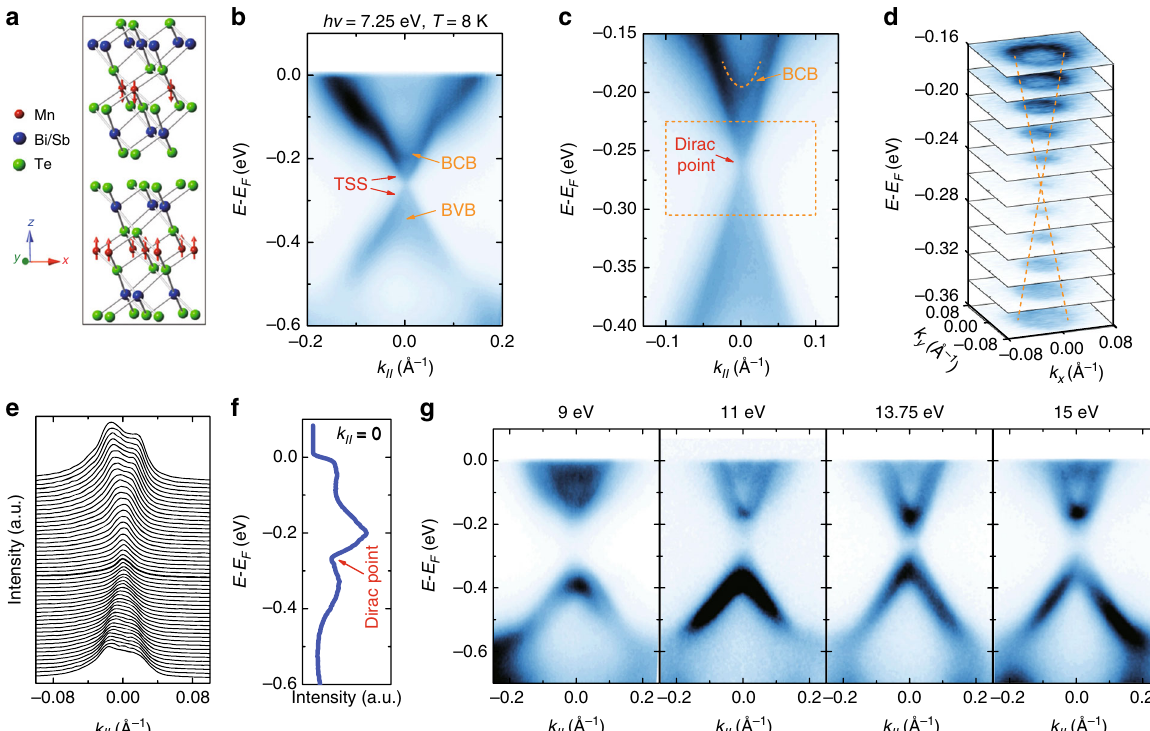
Fig. 1 ARPES measurements of the crystal with x = 0. a Crystal structure of the material family. The red arrows indicate the magnetic moment of the manganese atoms. b , c ARPES data of the crystal and the corresponding magni fi ed view near the Dirac point, under a photon energy of 7.25eV at 8 K. The arrows in b , c indicate the bulk conduction band (BCB), bulk valence band (BVB), and the topological surface states (TSSs), respectively. d Constant-energy maps at binding energies from − 0.16 to − 0.36 eV (photon energy = 7.25 eV, T = 8 K). e Momentum distribution curves derived from the ARPES spectrum in the dashed rectangle area in c . f The energy distribution curve extracted from the ARPES spectrum in b at k ∥ = 0. g Dispersions of the x = 0 crystal under photon energies from 9 to 15